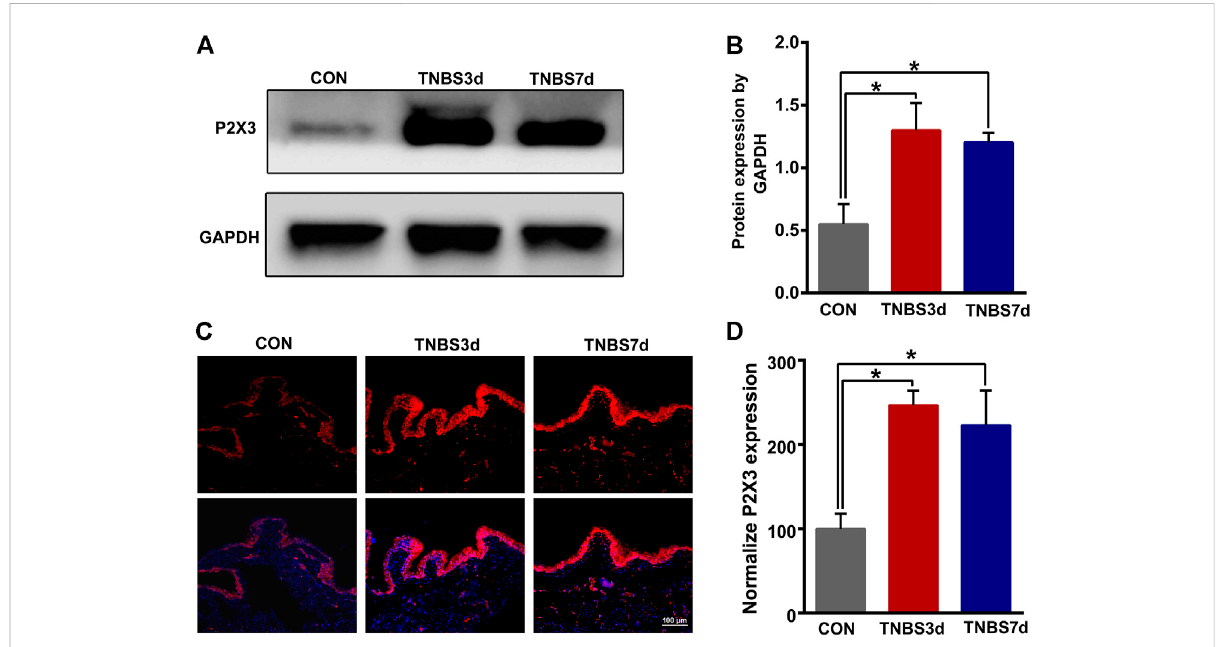
FIGURE 3 TNBS-induced colitis increased P2X3 expression in the bladder. (A – B) Western blotting showed that TNBS-induced colitis signi fi cantly increased theproteinexpression oftheP2X3receptorinthebladder. n=3for eachgroup. (C – D) P2X3immunoreactivityinthebladder showedthat colitis signi fi cantly increased P2X3 expression of the urothelium of the bladder at days 3 and 7 post-TNBS compared to the control group. Bar = 100 μ m; n = 4 for each group. * p < 0.05 by one-way ANOVA followed by Newman – Keuls post hoc